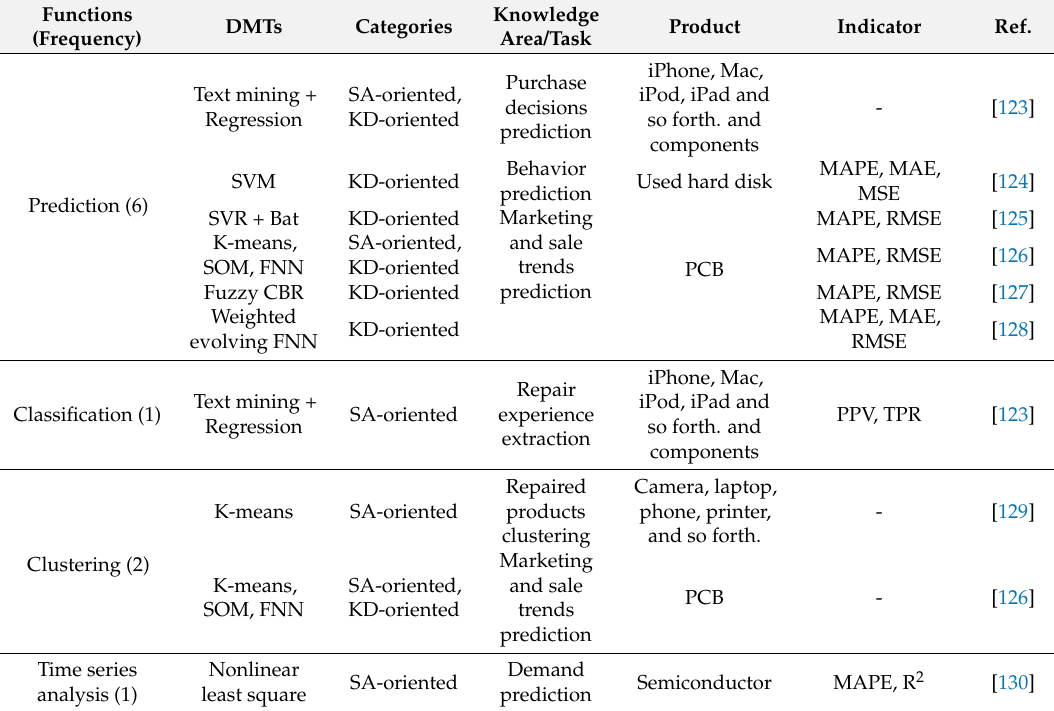
Table 13. DM and Big Data application in the sale, service and recycling